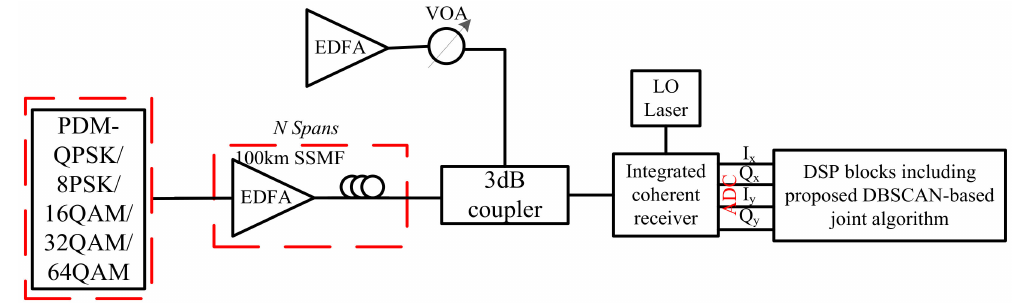
Figure 6. Simulation setup to utilize the DBSCAN-based joint